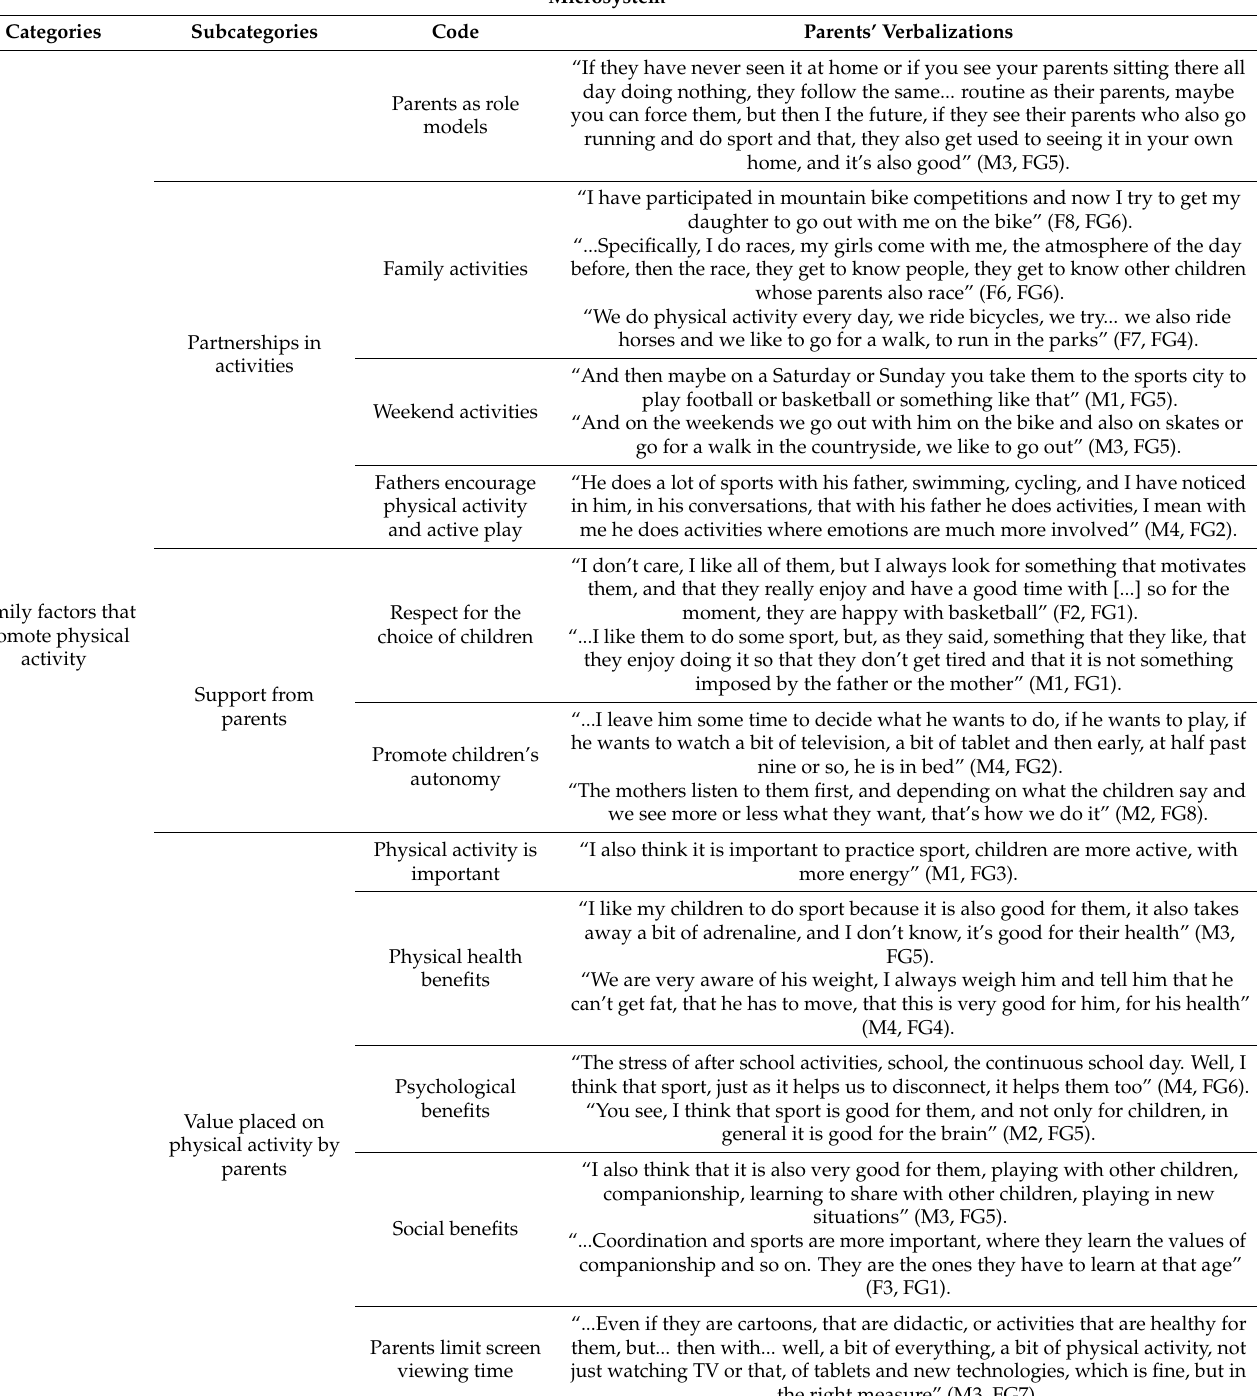
Table 9. Microsystem facilitators for physical activity among